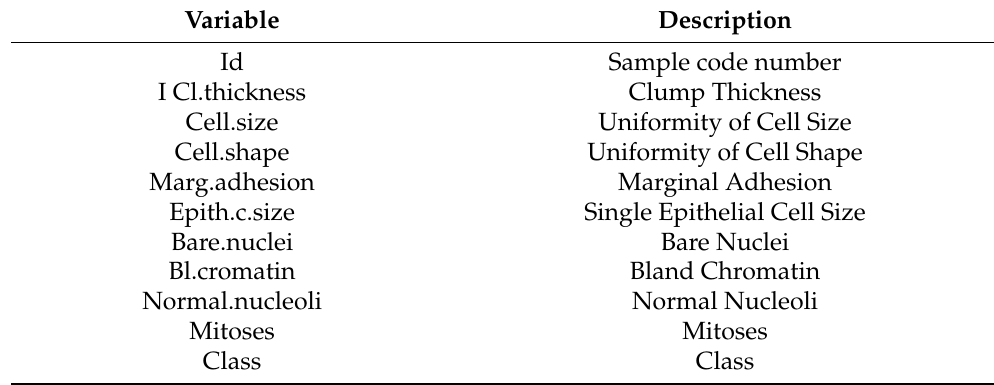
Table 1. Name of variables and description for the heart disease